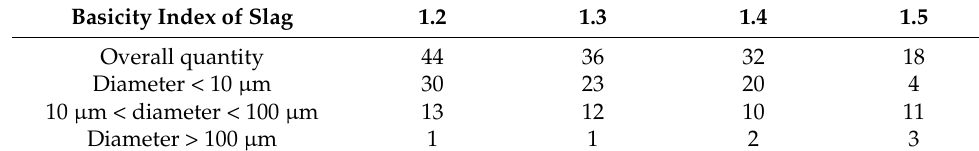
Figure 2. Effect of slag basicity index on the overall number of silicon droplets at the silicon–slag interface (inspection area: 1 mm × 1 mm). Table 3. Statistics of silicon droplets with different sizes (in a 1 mm × 1 mm area).